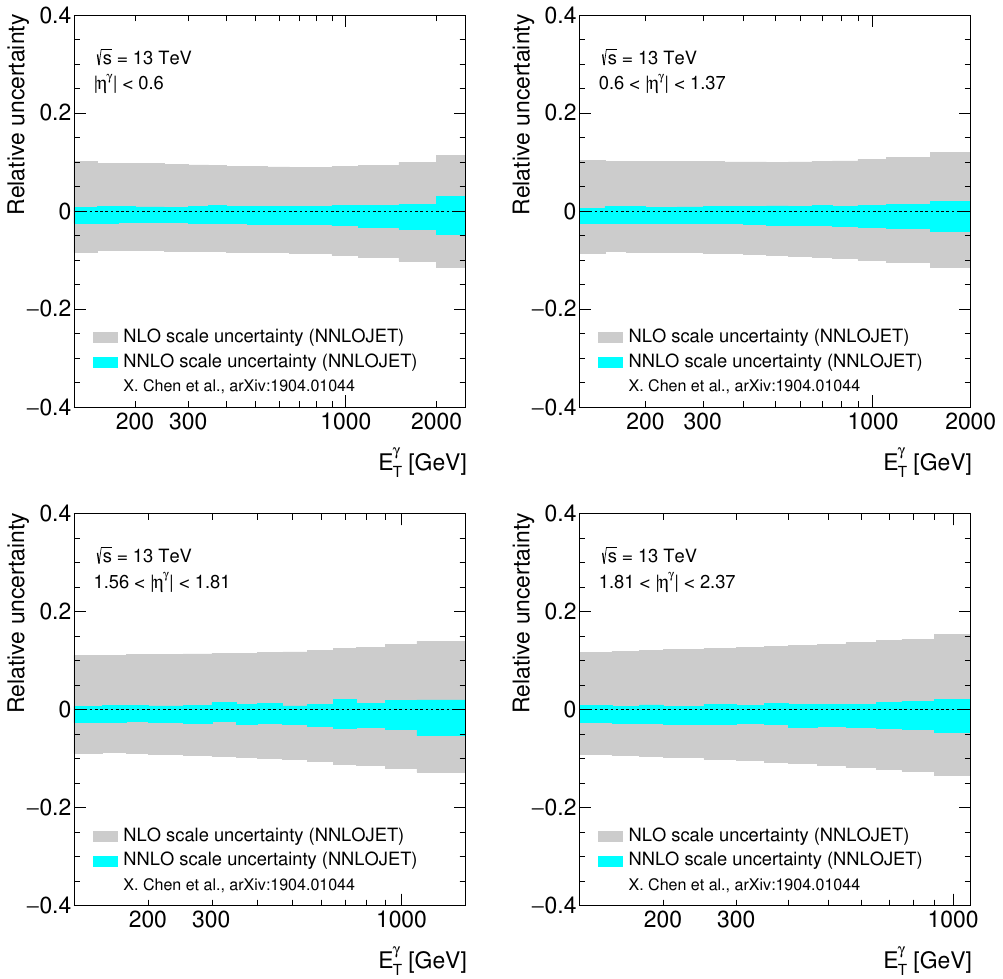
Figure 5 . The relative theoretical uncertainty in the cross-section prediction of Nnlojet arising from the scale variations as a function of E (cid:13) predictions.